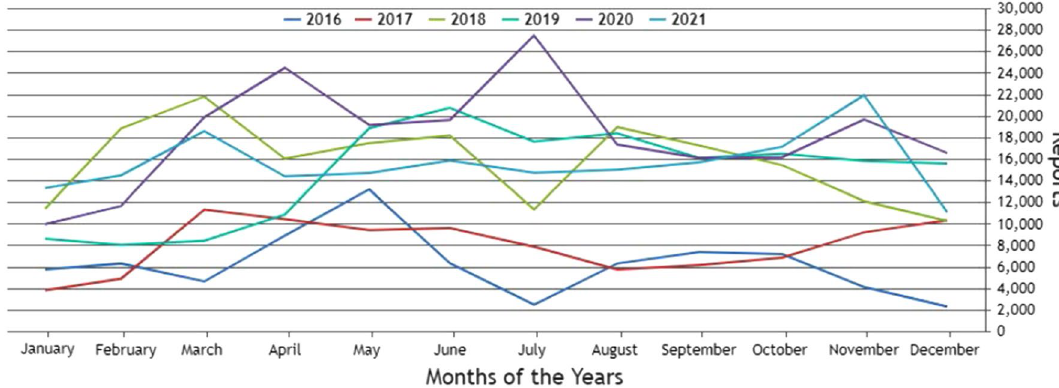
Figure 19. Summary of phishing reports over the 2016 to 2021.